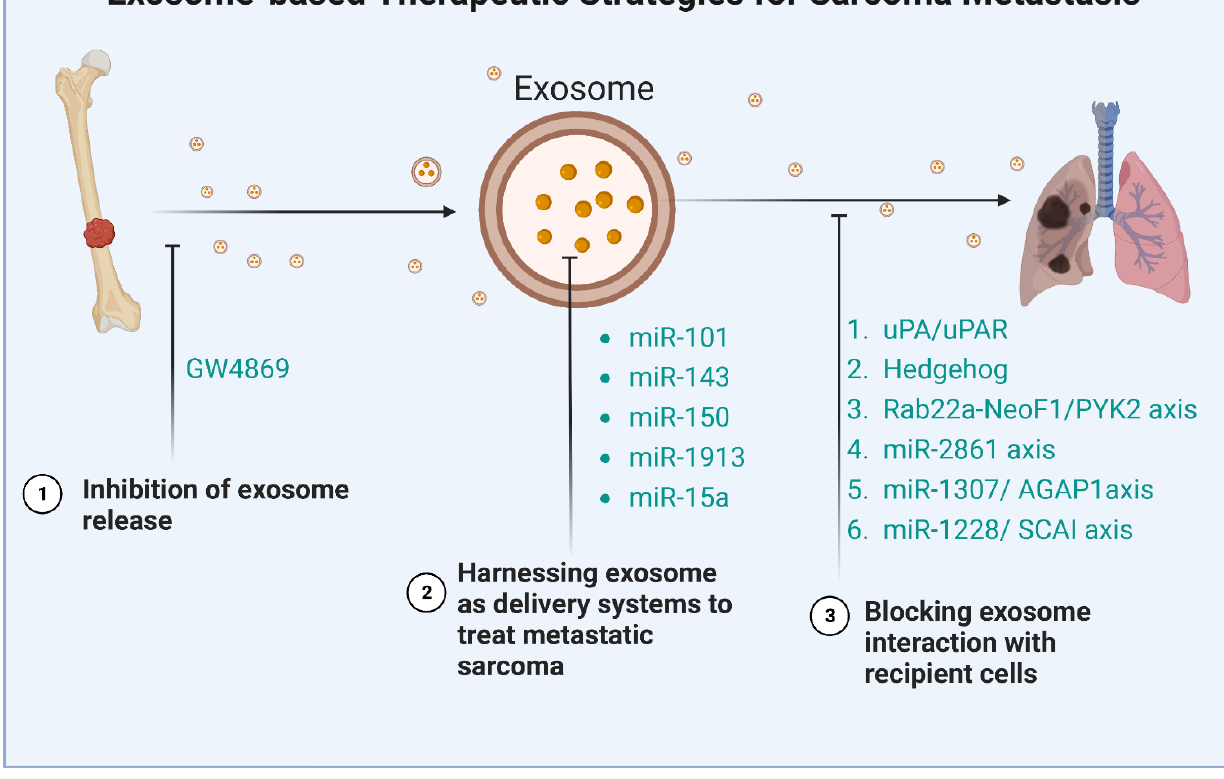
Figure 3. Therapeutic strategies using exosomes in sarcoma metastasis.